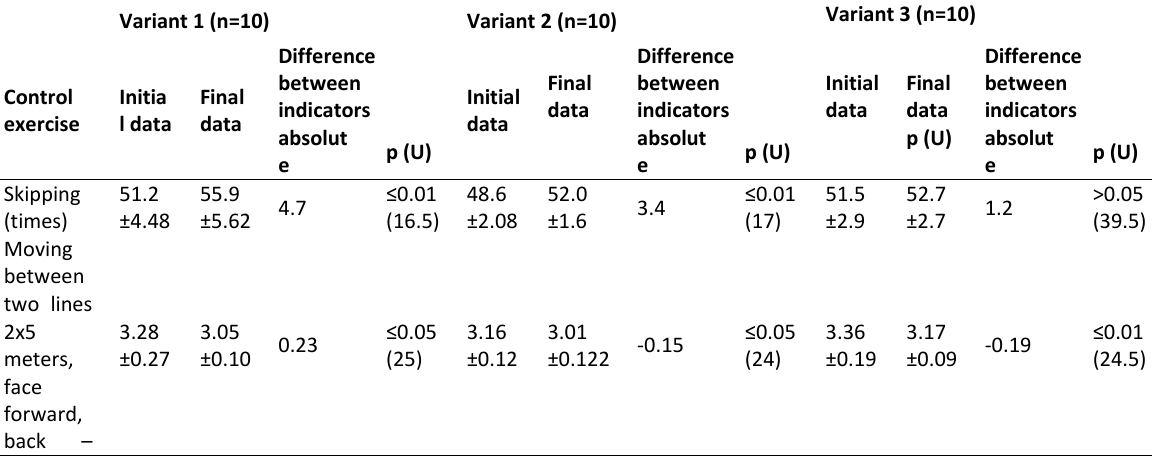
Table. Effectiveness of first variant of training means’ modules combination for badminton players’ speed-power training at stage of specialized preparation